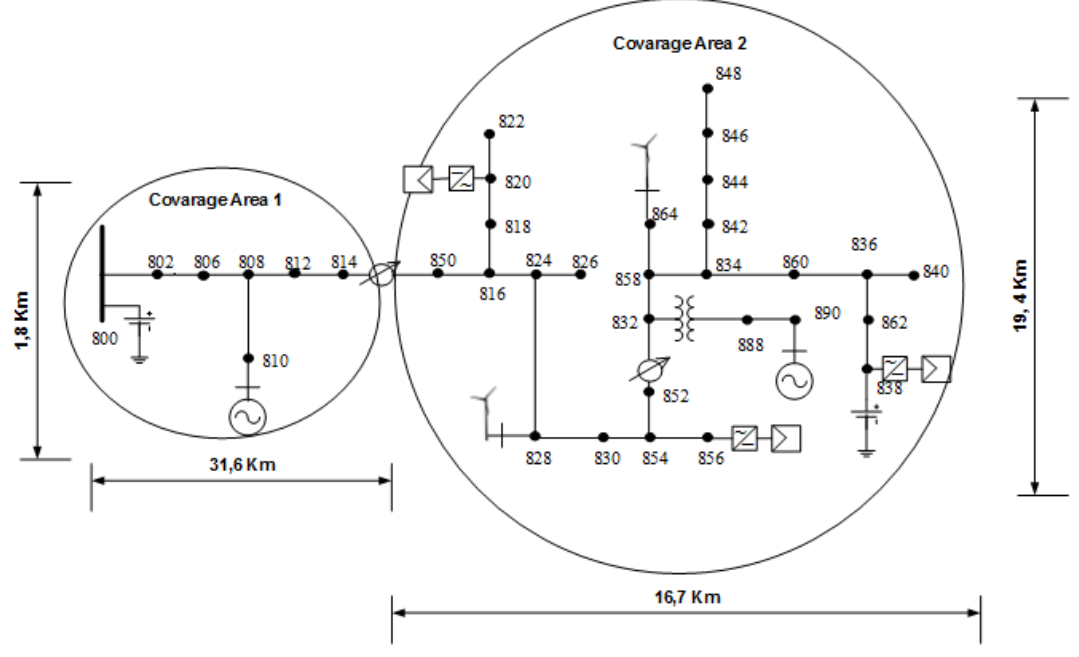
Figure 1. Modified distribution system model with distributed energy